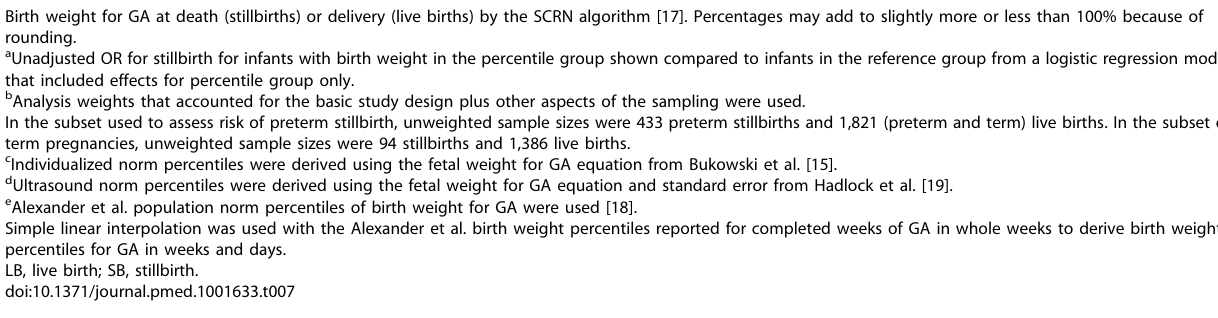
Birth Weight Norms and Percentiles Preterm SB and All